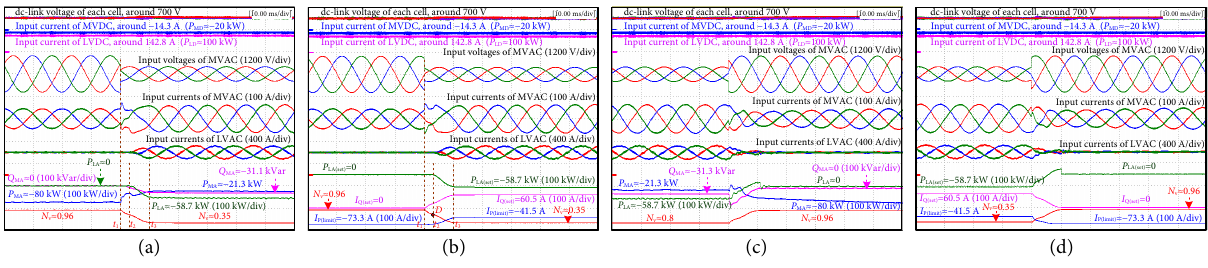
Fig. 16 Experimental results of LVRT Mode-1 in Case-1 of active-power configuration. (a) Real-time power curve in the voltage sag process. (b) Power command curve in the voltage sag process. (c) Real-time power curve in the voltage recovery process. (d) Power command curve in the voltage recovery process.